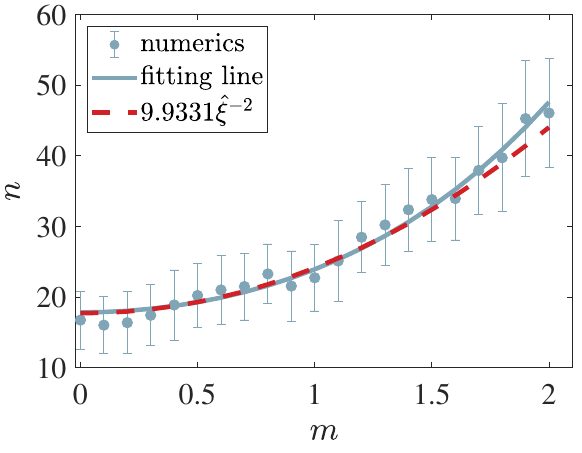
Figure 4 . Vortex number n versus the graviton mass m . Blue solid dots and error bars are from numerical data while blue line is the best fit as n ≈ 17 . 82 × the standard deviations. From the relation n ≈ Ap ˆ ξ − 2 in eq. (2.4), the numerical data from QNMs analysis in the right panel of figure 3 can be recast into the red dashed line to link the relations between n and m . The blue solid line matches very well with the red dashed line as m . 1 . 5 .